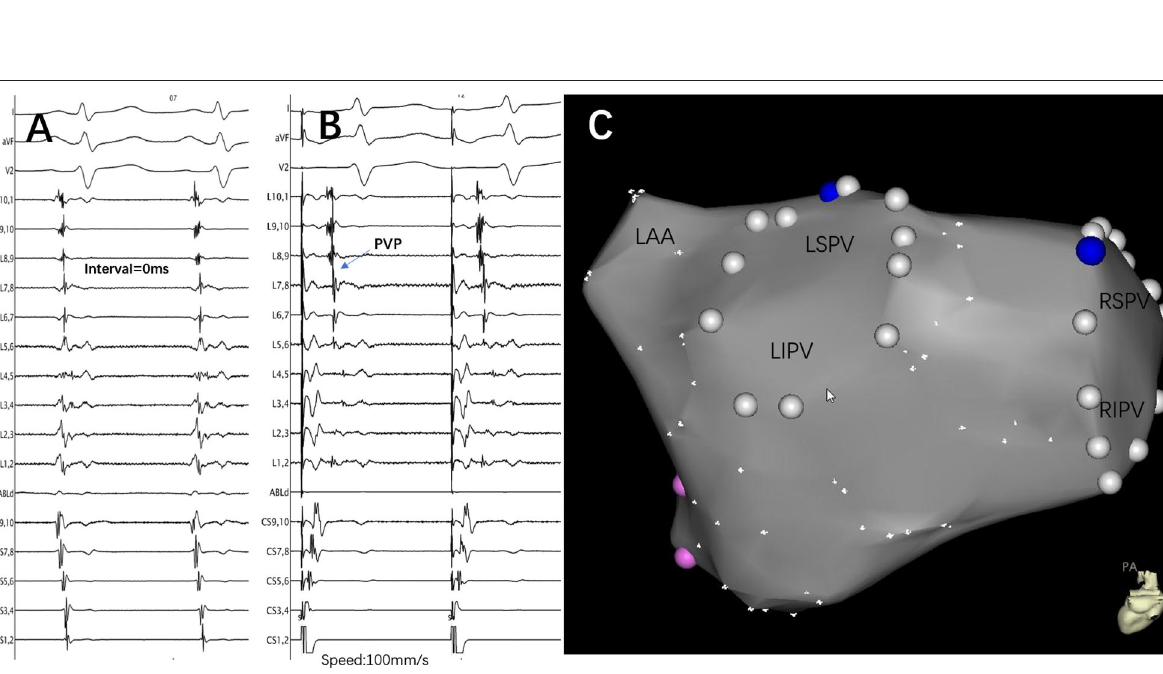
Frontiers in Cardiovascular Medicine | www.frontiersin.org